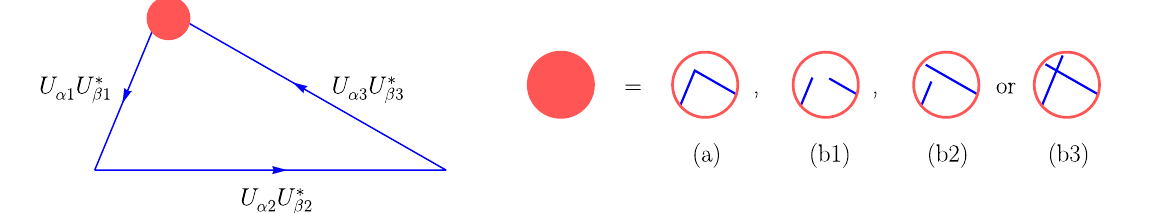
Fig. 1 The schematic plot of an effective Dirac-type unitarity triangle and four typical topologies of its apex in the complex plane based on the ( 3 + n ) active-sterile neutrino mixing scheme, where (α,β) = ( e ,μ) , (μ,τ) or (τ, e ) . As for the effective apex in red, pattern a corresponds to